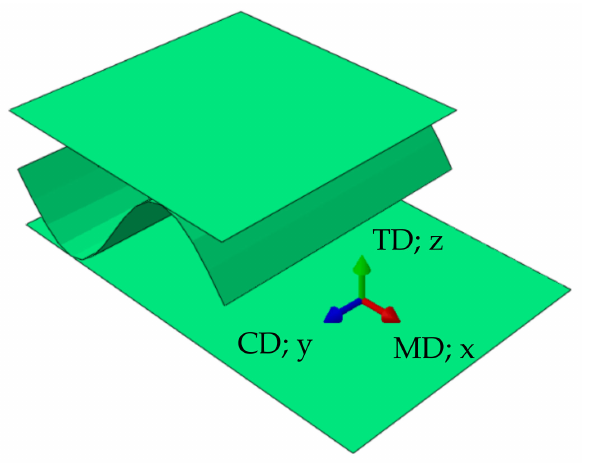
Figure 1. Material